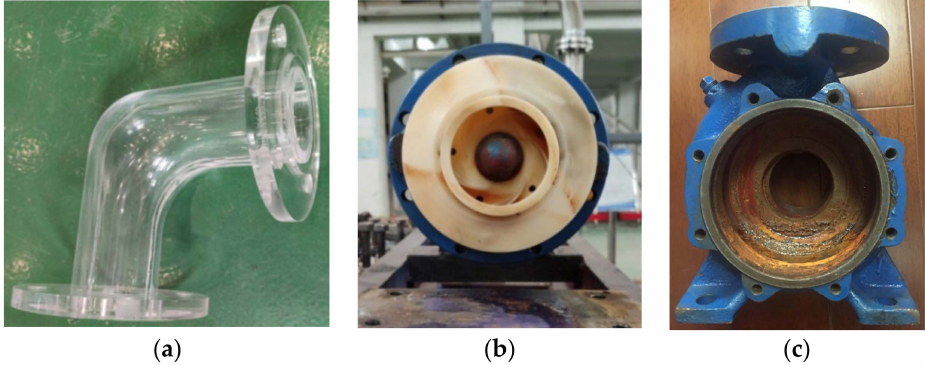
Figure 1. Centrifugal pump model. ( a ) elbow inlet. ( b ) impeller. ( c )